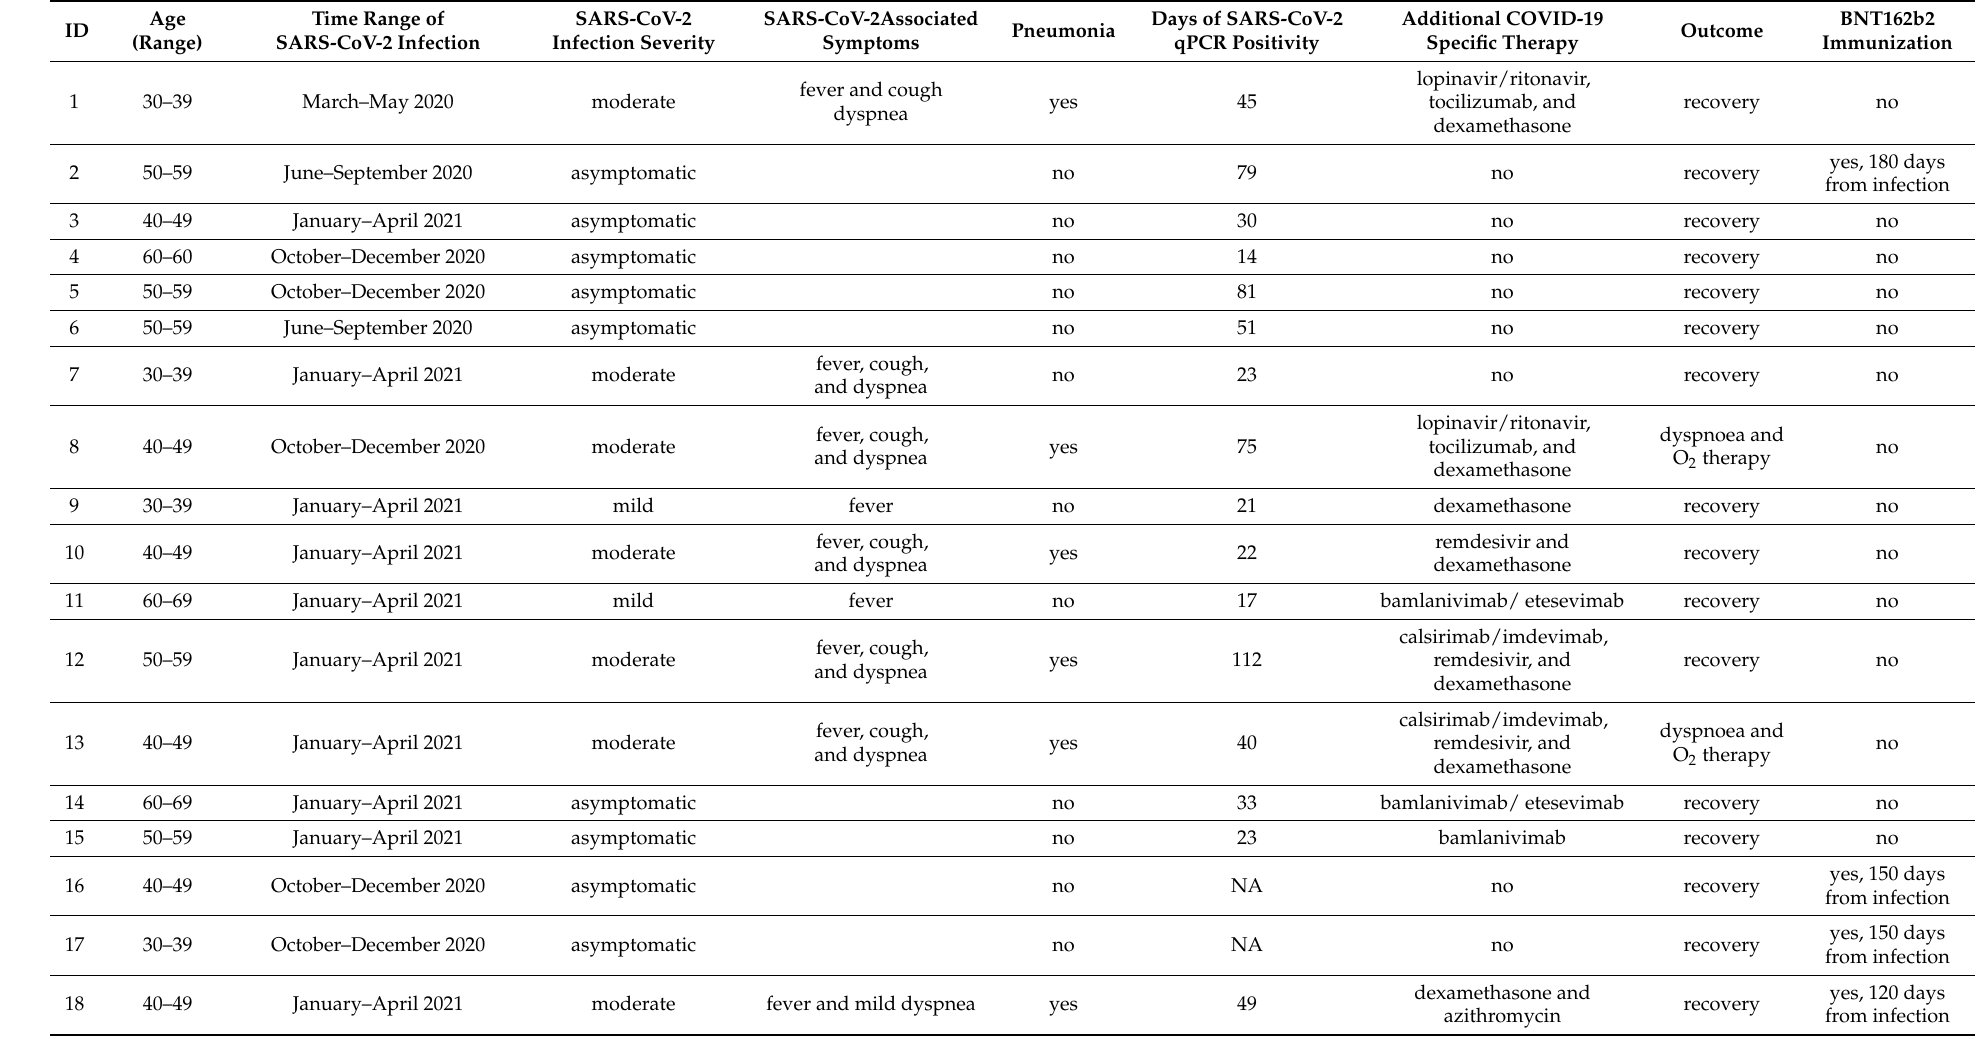
Table 2. SARS-CoV-2 infections, treatments, and outcomes in 34 CVID